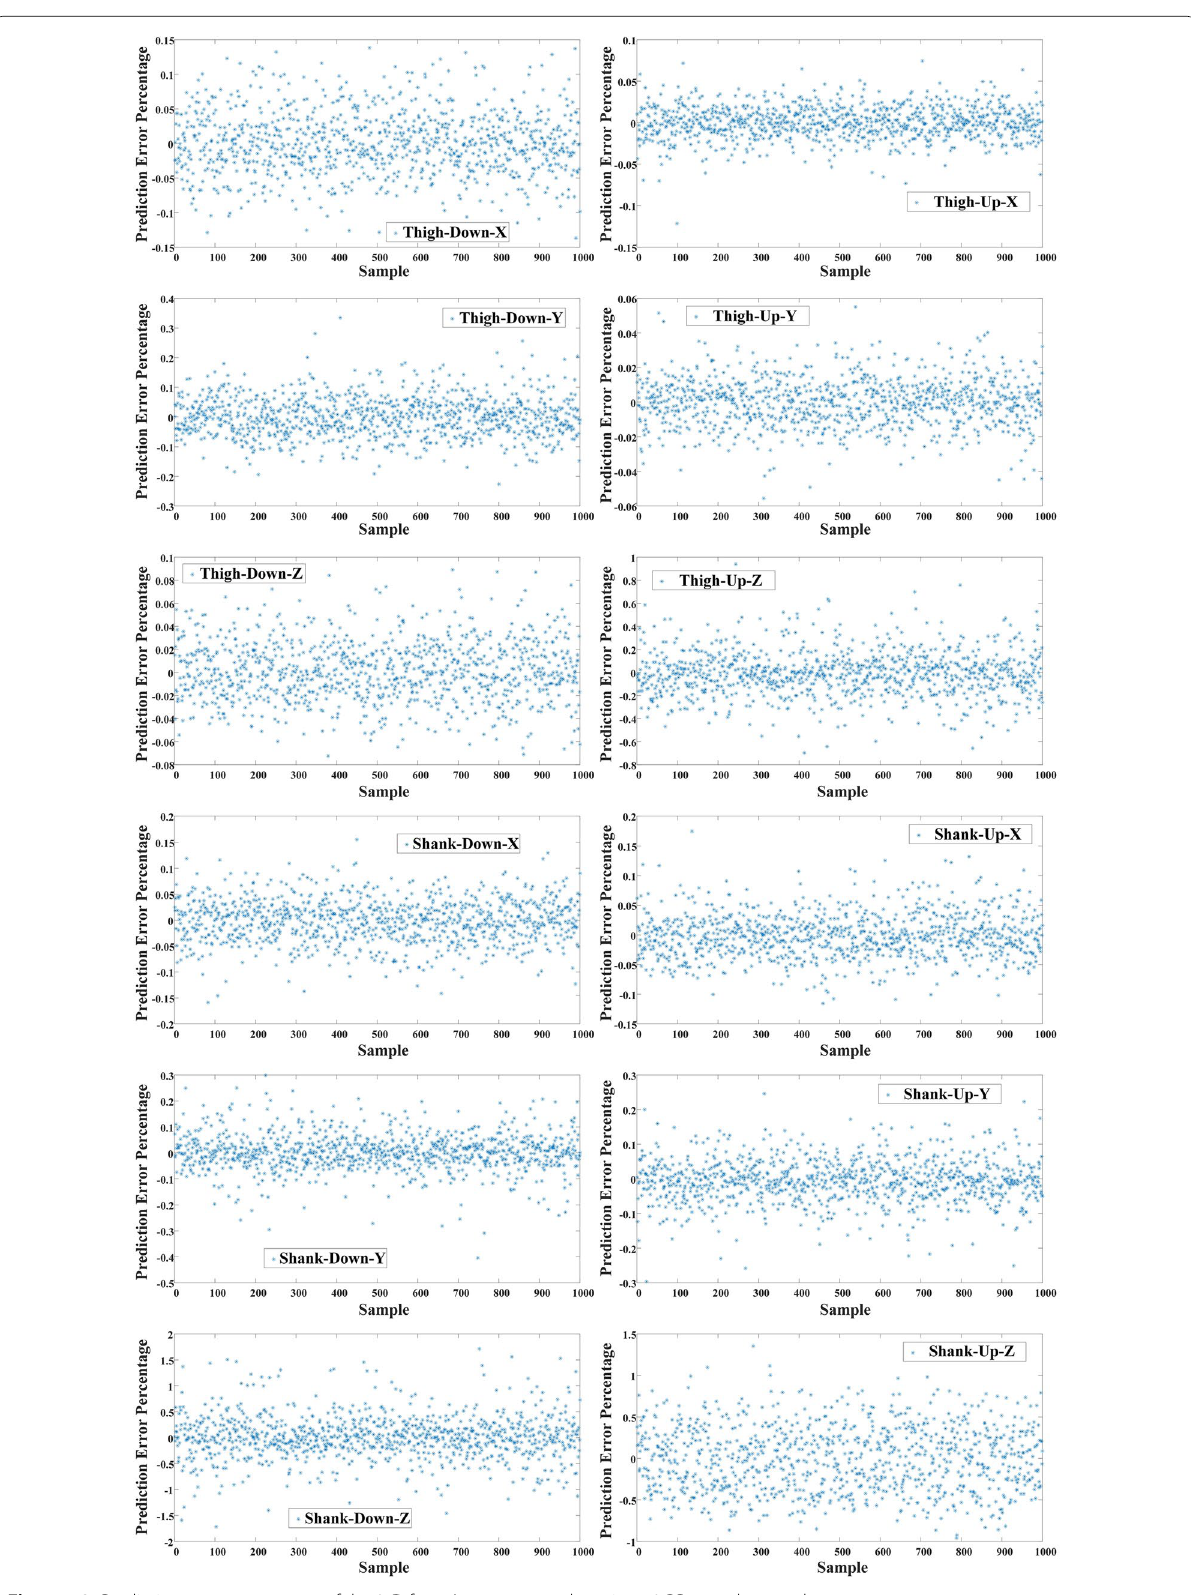
Figure 10 Prediction error percentage of the 3-D force/torque sensor by using 12 BP neural